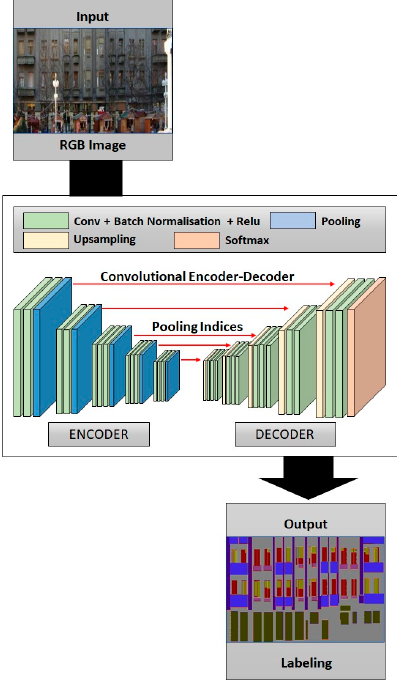
Figure 3. The SegNet architecture.